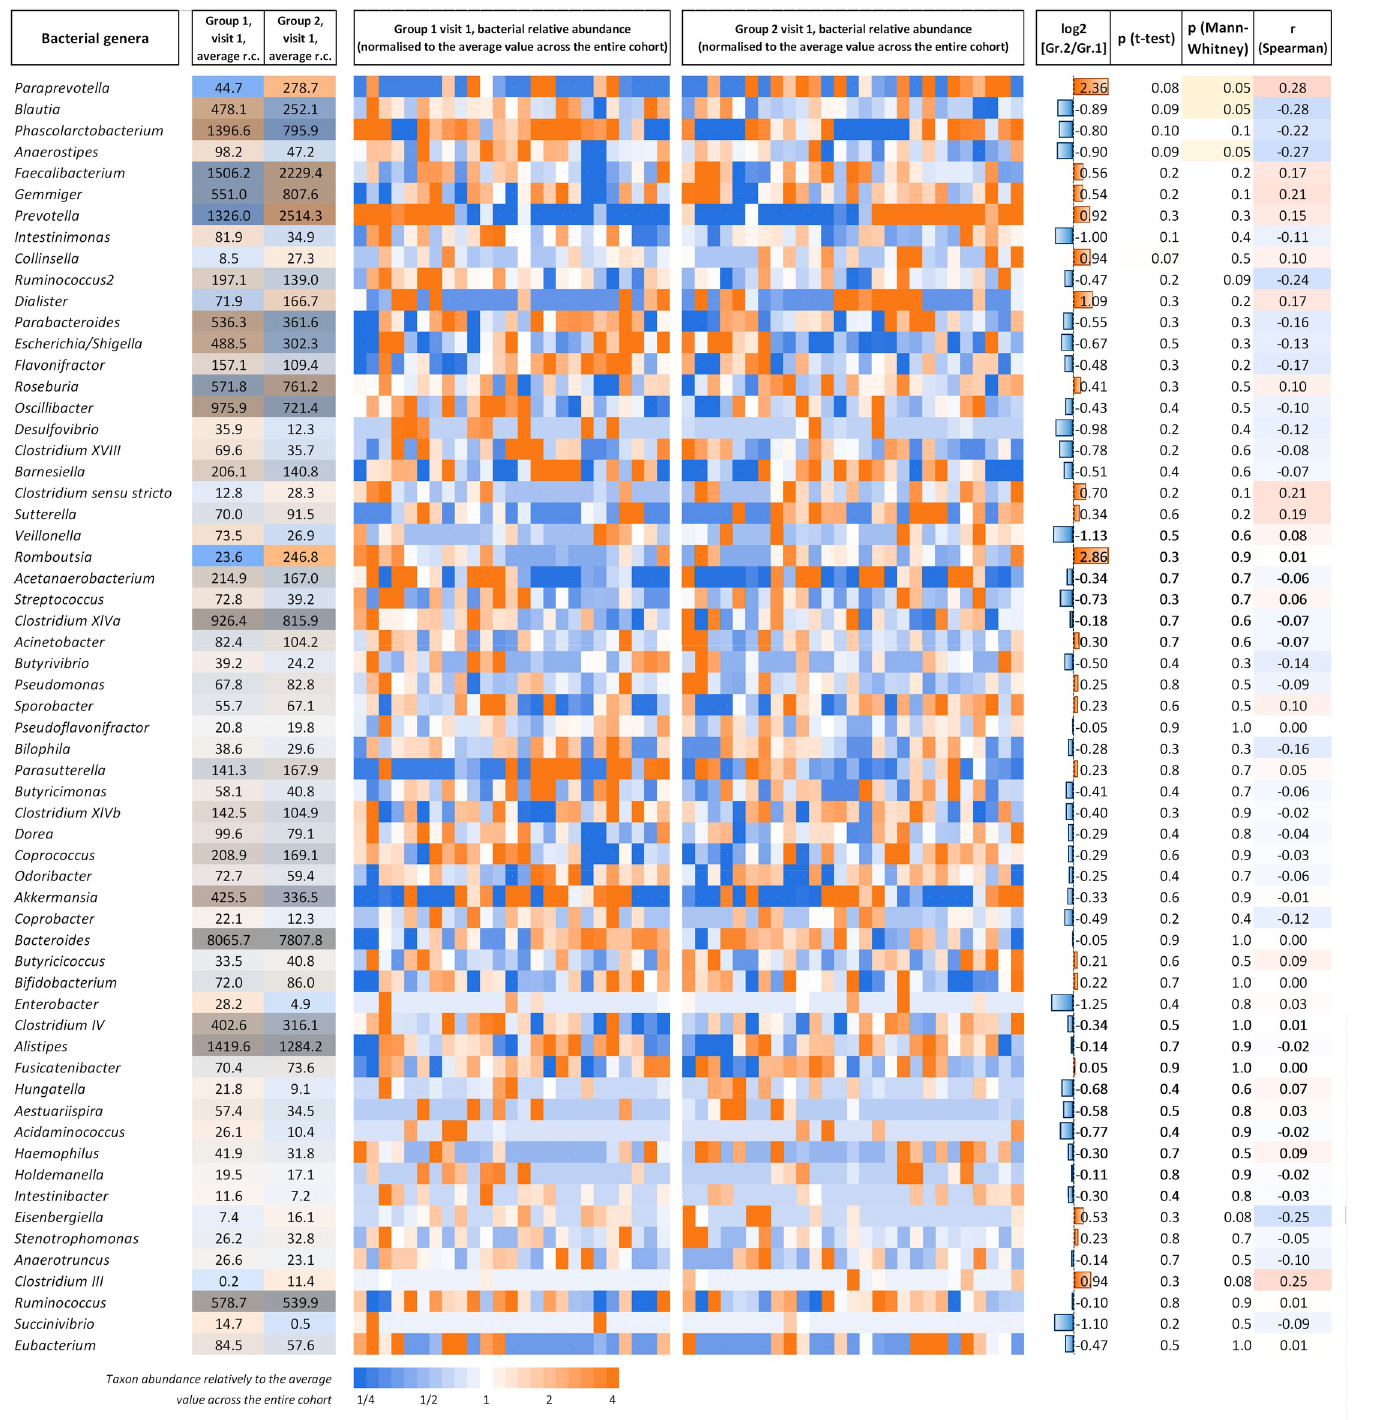
Fig 3. Qualitative and quantitative composition of the intestinal microbiota genera in patients of groups 1 and 2 at visit 1. Columns 2 and 3 present the relative bacterial content of a given genus (r.c., represents the normalized number of reads annotated to the current genus) averaged over all samples of a group. The color brightness reflects the average content, whereas the color hue (blue to orange) indicates the difference between the groups. The heatmaps in columns 4 and 5 show the bacterial content profiles of the genera for individual samples. The genera are sorted by a scoring factor, which reflects the magnitude of differences between groups 1 and 2, statistical significance (based on the Mann-Whitney test), and the average bacterial content across all samples.